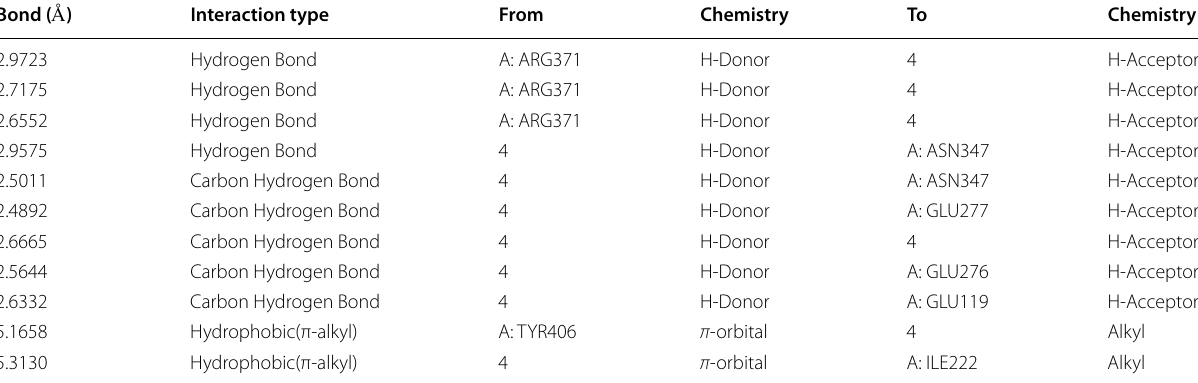
Table 13 Binding interaction of the H1N1 neuraminidase receptor with compound 4 Bond ( Å ) Interaction type From Chemistry